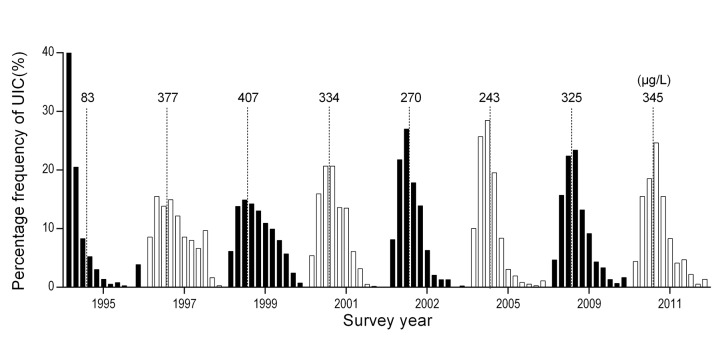
Distribution of concentration of urinary iodine (UIC) in the surveys.The UIC in each survey was categorized into 11 groups by UIC <100 μg/L, < 200 μg/L, etc. to < 1,000 μg/L and ≥1,000 μg/L. Each bar represents the percentage frequency of one group. The dashed lines show the position of UIC = 300 μg/L. The number above each bar is the median UIC in each survey (unit: μg/L). This Fig shows that the distribution of UIC was concentrated around the median value, and few proportions with either very low or very high values were observed after 2000.